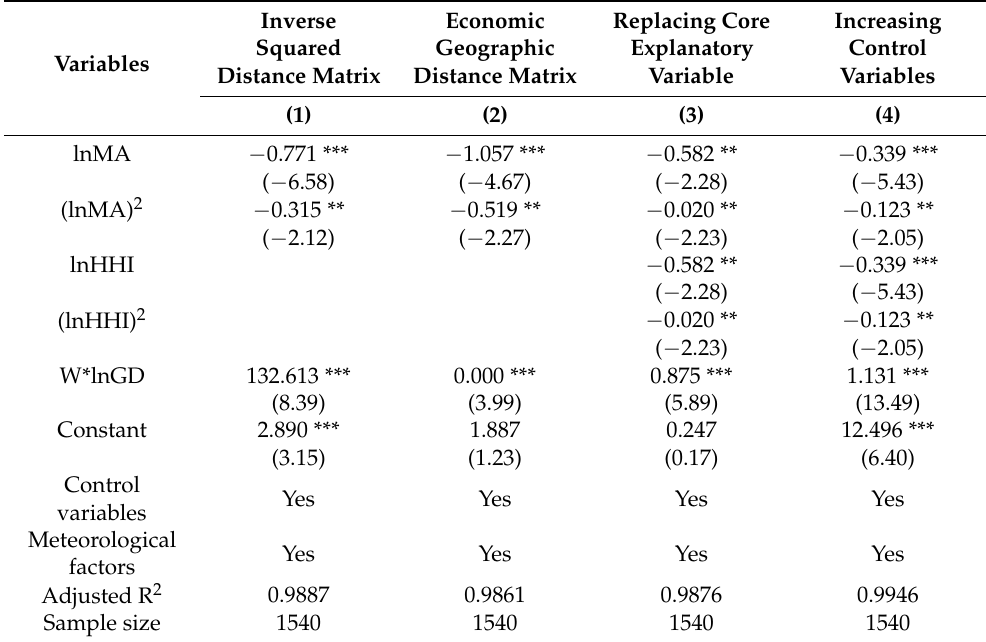
Table 3. Estimation results of robust